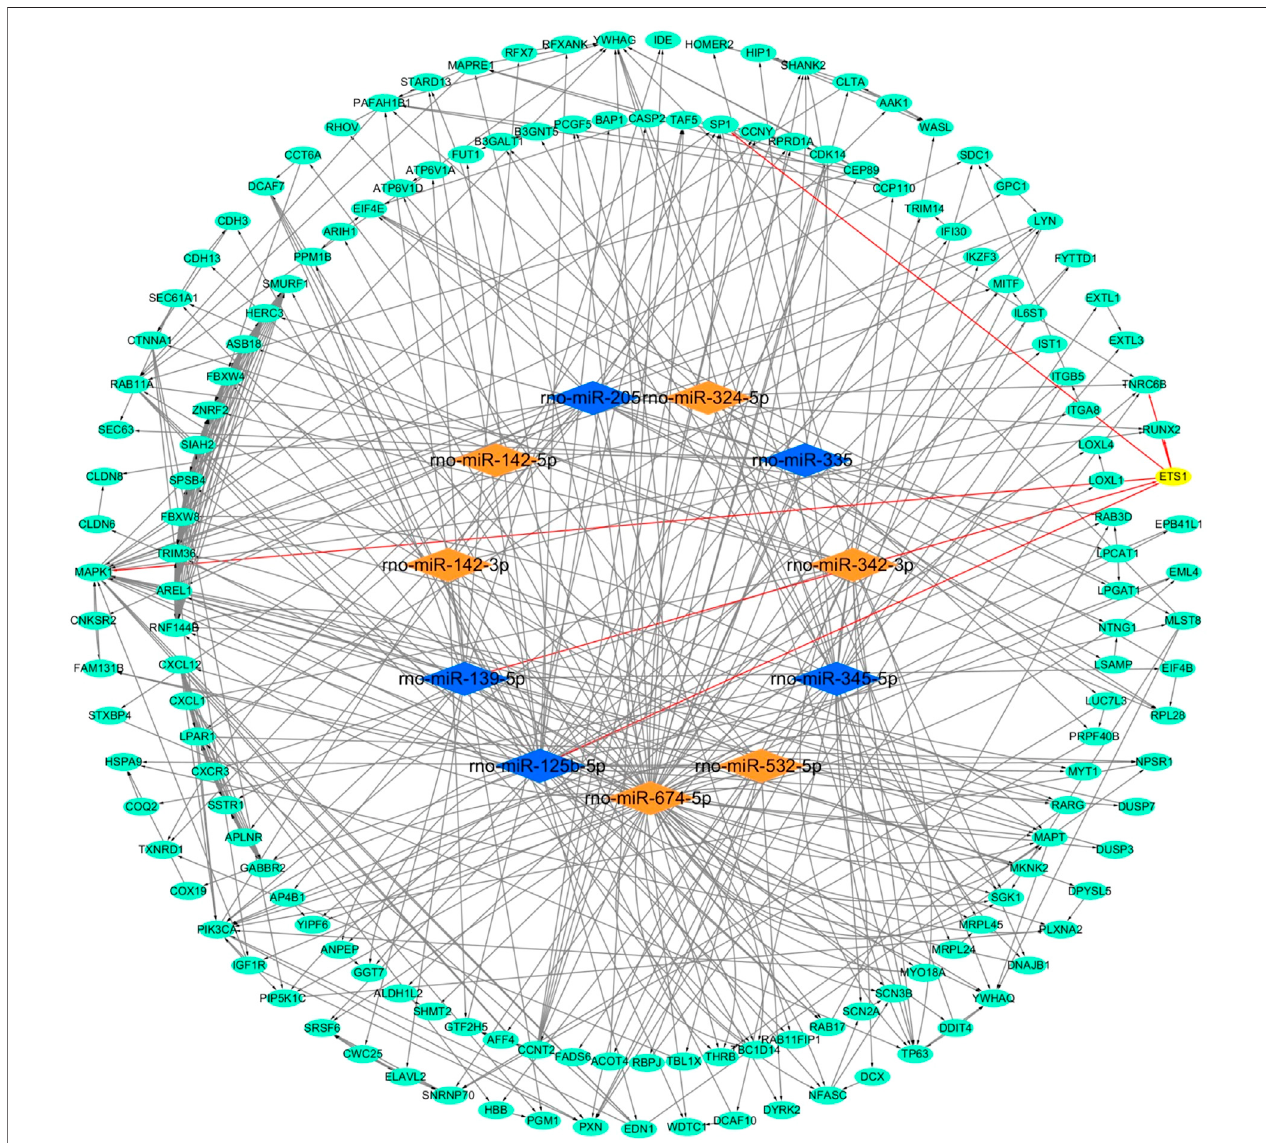
FIGURE4 | Network ofmiRNA-mRNA. Orange nodes: upregulated miRNAs. Blue nodes: downregulated miRNAs. Green nodes: target genes.Edgeswith arrow: miRNAs regulate target genes, or one of the target genes regulates another target gene. One example contains a yellow node and six red edges with an arrow.